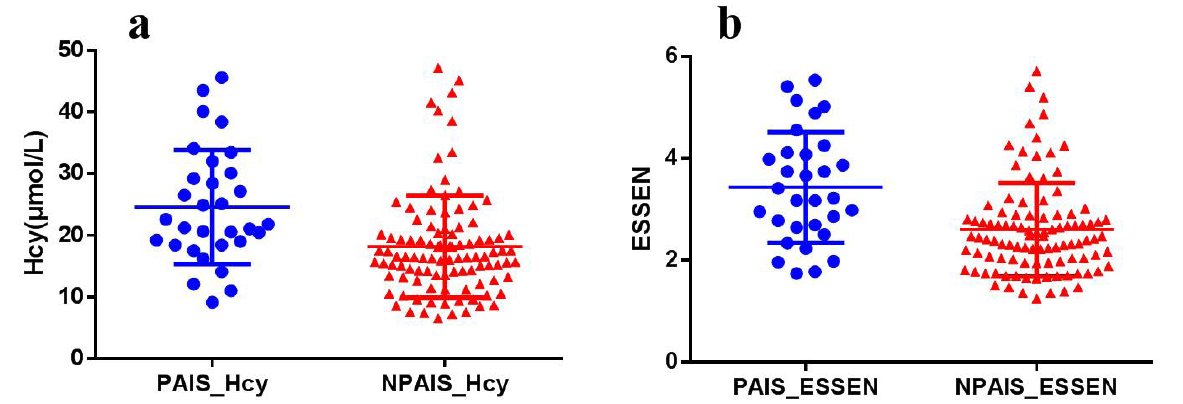
Figure 2: The scatter plot of serum homocysteine and ESRS between PAIS and NPAIS (a:serum Hcy; b: ESSEN score).